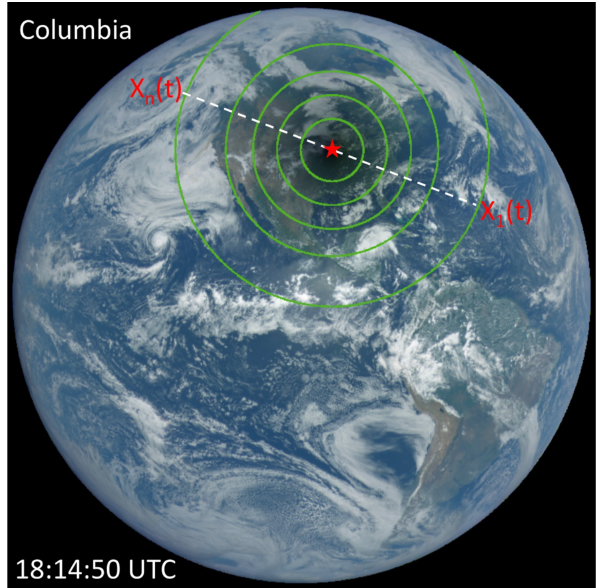
Figure 6. A sketch illustrating the conversion from temporal to spa- tial average. The color image has been adjusted from the images on https://epic.gsfc.nasa.gov (last access: 21 August 2020) by increas- ing the gamma correction (Cescatti, 2007) to bring out the region of totality over Columbia (red star) and surrounding clouds. The green contours show the levels of obscuration from 0% for the outmost circle with a decrement of 20% inward. The dashed line illustrates the totality